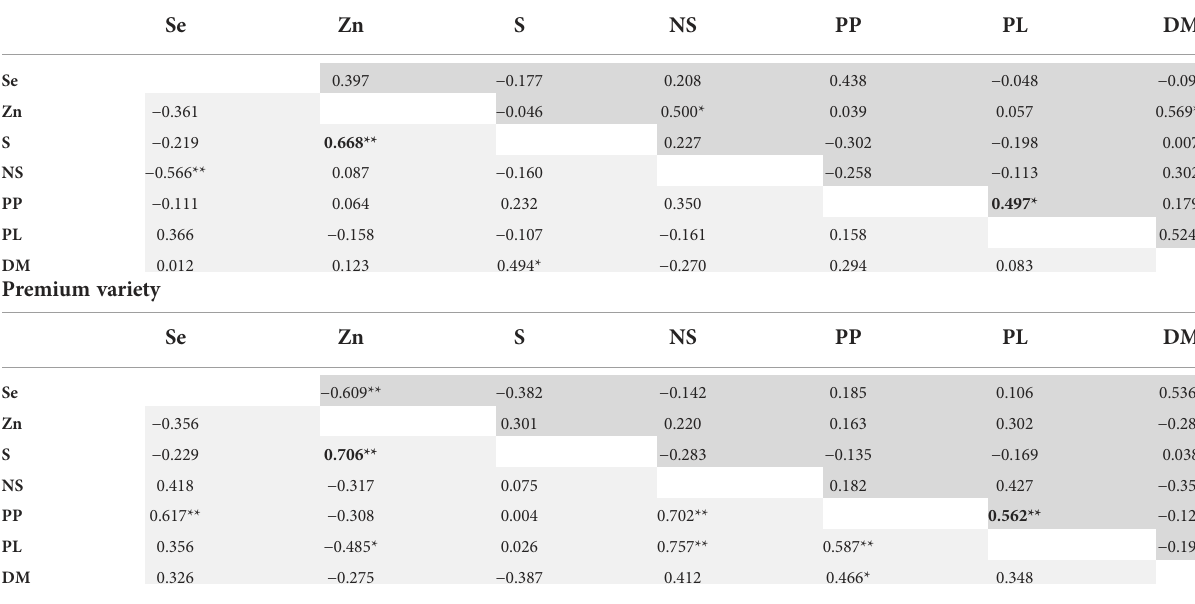
TABLE 4 Pearson correlation coef fi cients between seed mineral concentrations and growth parameters evaluated for two pea varieties (Ambassador and Premium) grown in two seasons (2014 and 2015). Ambassador variety